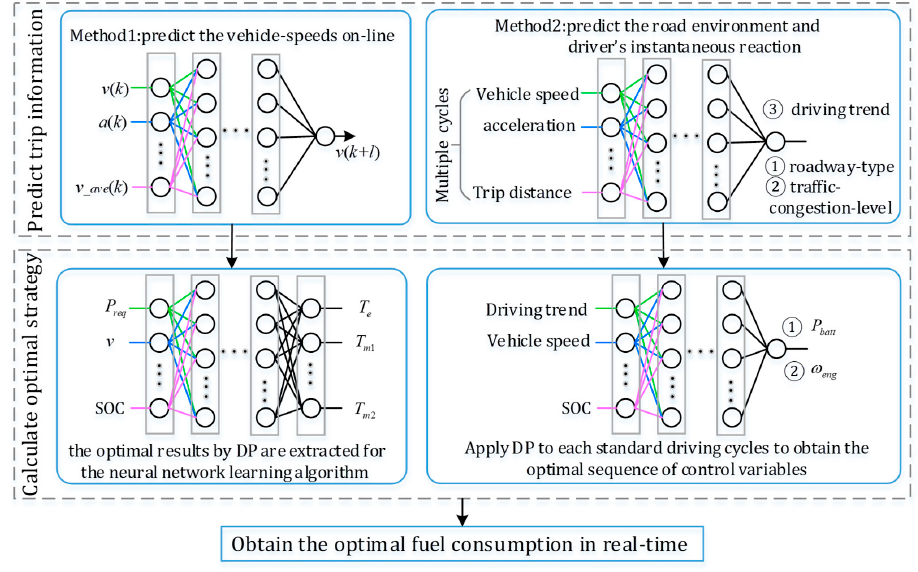
Figure 9. Description of the main research areas for the NN-DP-based strategy.